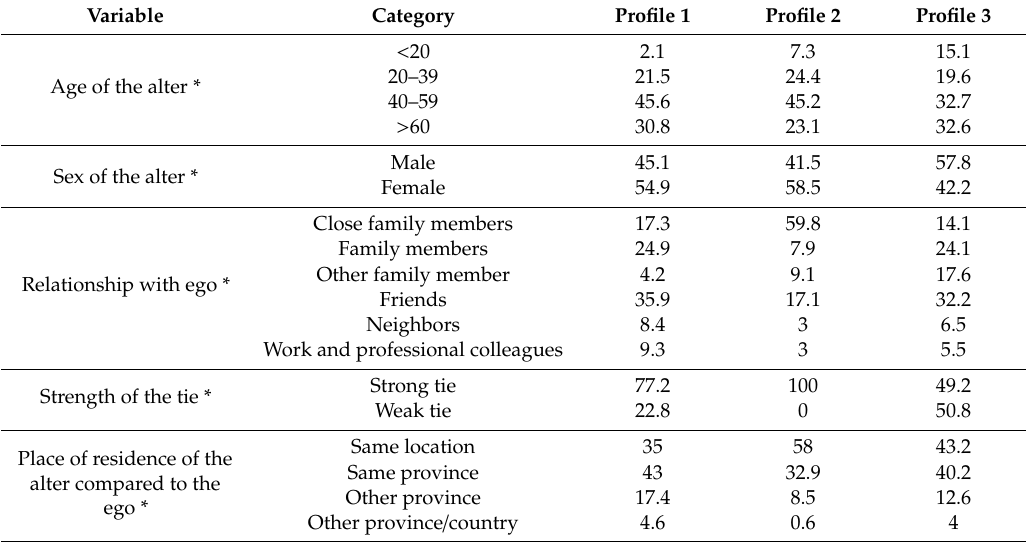
Table 5. Composition variables of the personal network according to the three profiles (%).